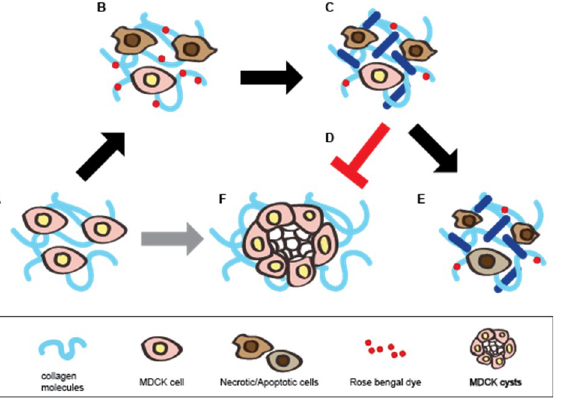
Scheme 1. Schematic diagram of the mechanism of action of the glycerol-Rose Bengal-polidocanol foam. (A, F) MDCK cells proliferate and form a cyst (F) when cultured in a collagen matrix (A). (B) When treated with the Rose Bengal foam, polidocanol affects the cell membrane by ultimately killing the cells while Rose Bengal dyes the collagen matrix. (C) Green light activates the Rose Bengal and reactive oxygen species when Rose Bengal is emitted. (D, E) MDCK cells fail to proliferate and form a cyst (D) and fail to proliferate as the untreated cells (E). The dark blue line represents collagen crosslinking.